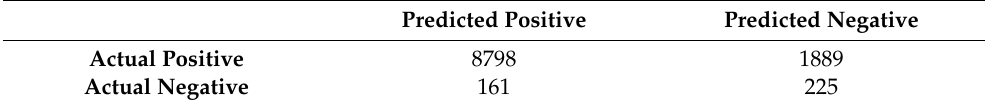
Table 3. Adaboost confusion matrix.